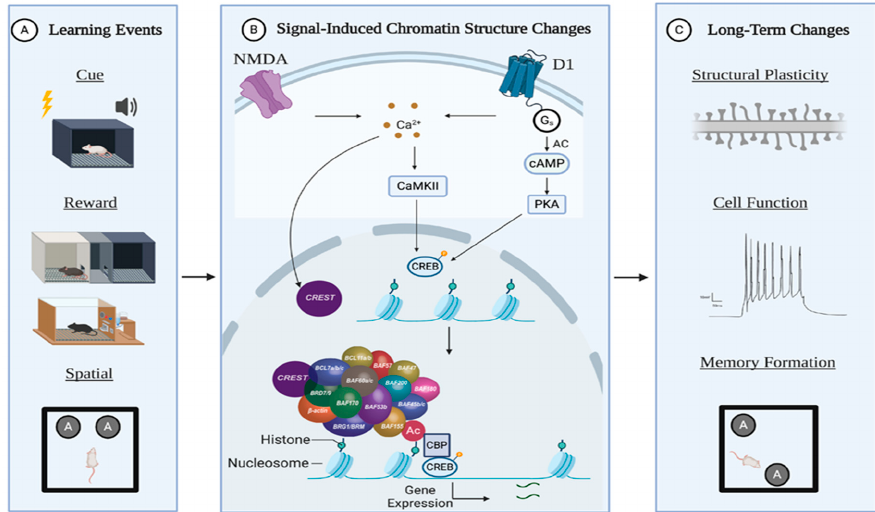
Figure 1. Model for recruitment of nBAF complex and histone acetylases in plasticity-associated events. Long-term memory formation learning about environment for optimizing future behaviors.